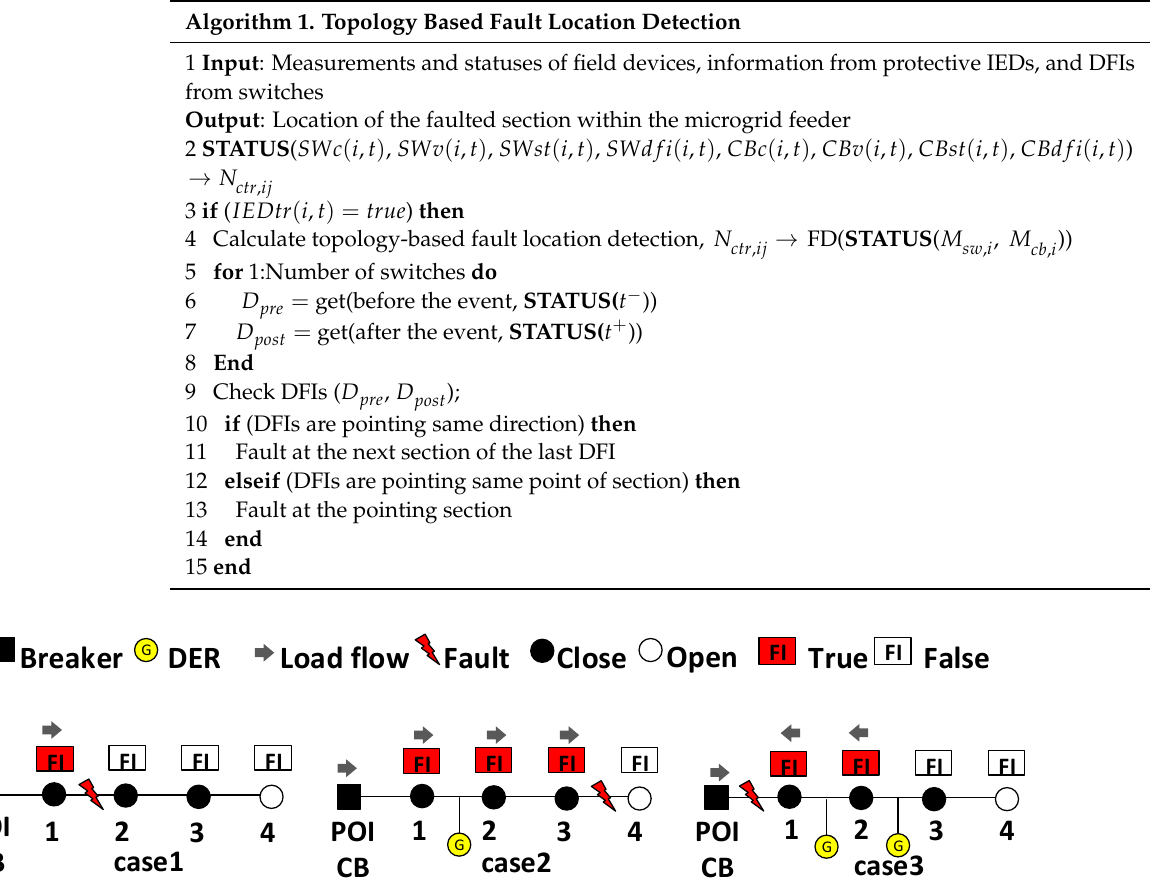
Algorithm 1. Topology Based Fault Location Detection